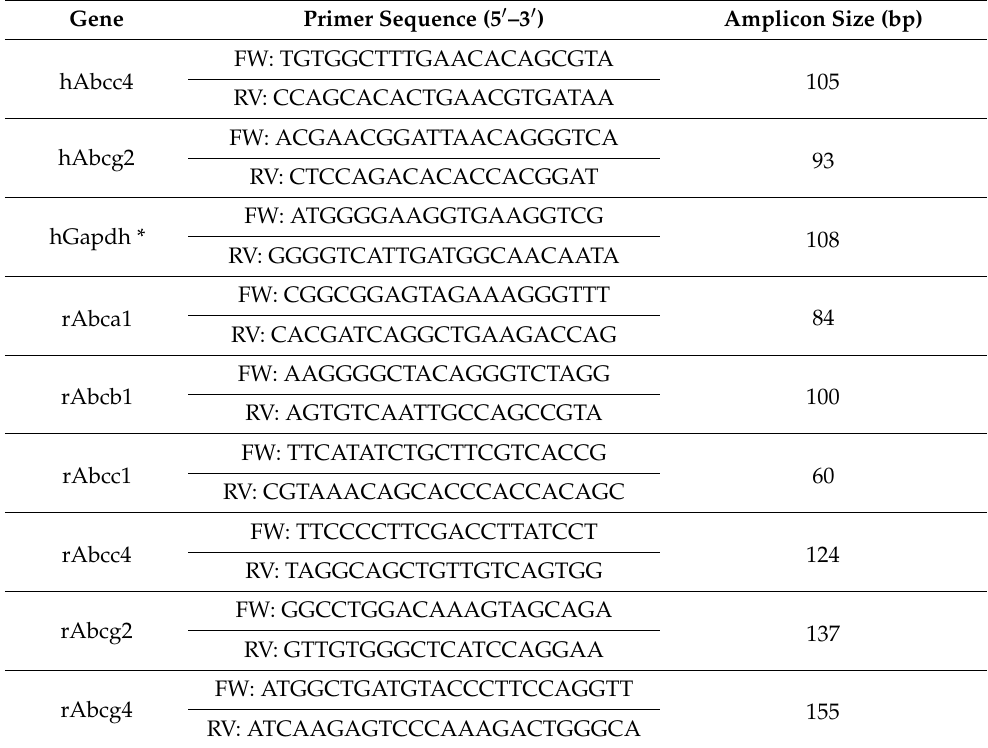
Table 3. Primers and amplicons sizes used for real-time quantitative